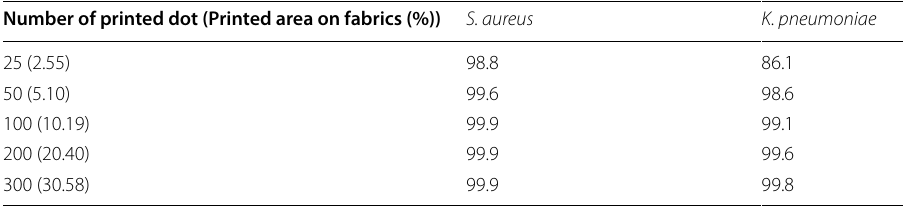
Table 2 Antibacterial ability of gallotannin printed cotton fabrics as a function of the number of gallotannin printed dots on 210 297 mm cotton fabrics × Number of printed dot (Printed area on fabrics (%)) S.